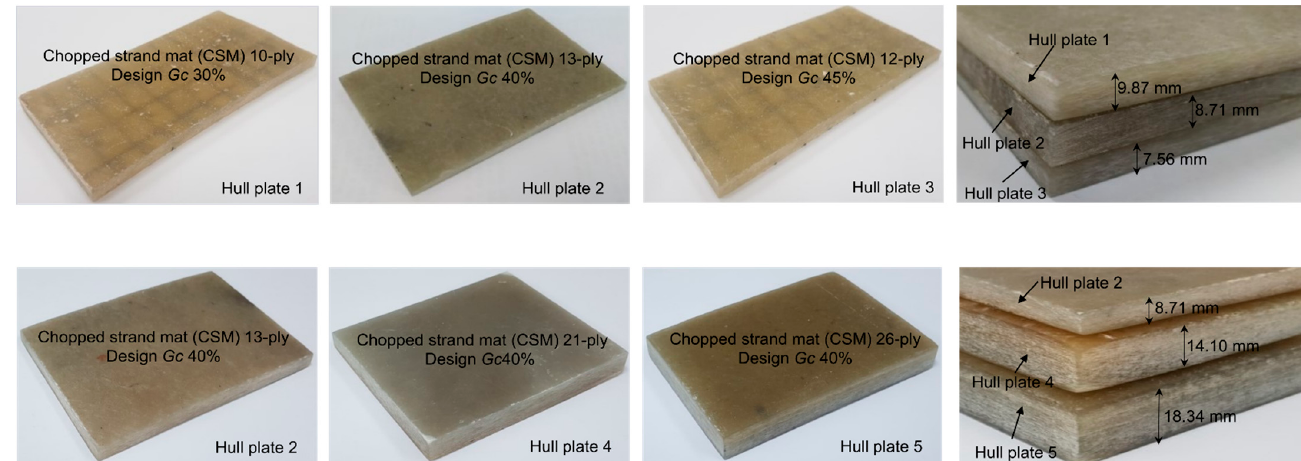
Figure 2. Prototype hull plates fabricated according to the design plan.